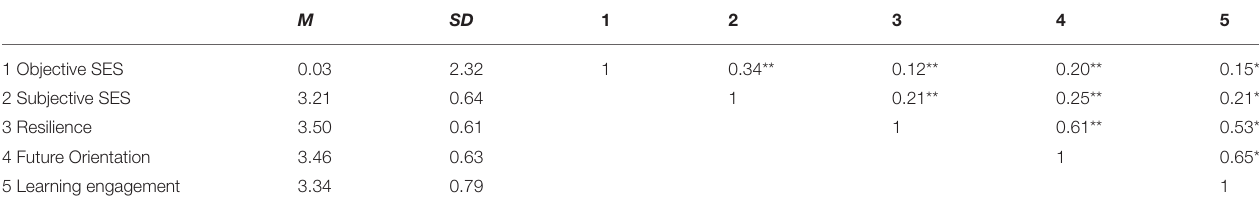
TABLE 1 | Descriptive statistics and inter-correlations between study variables ( N = 1,245). M SD